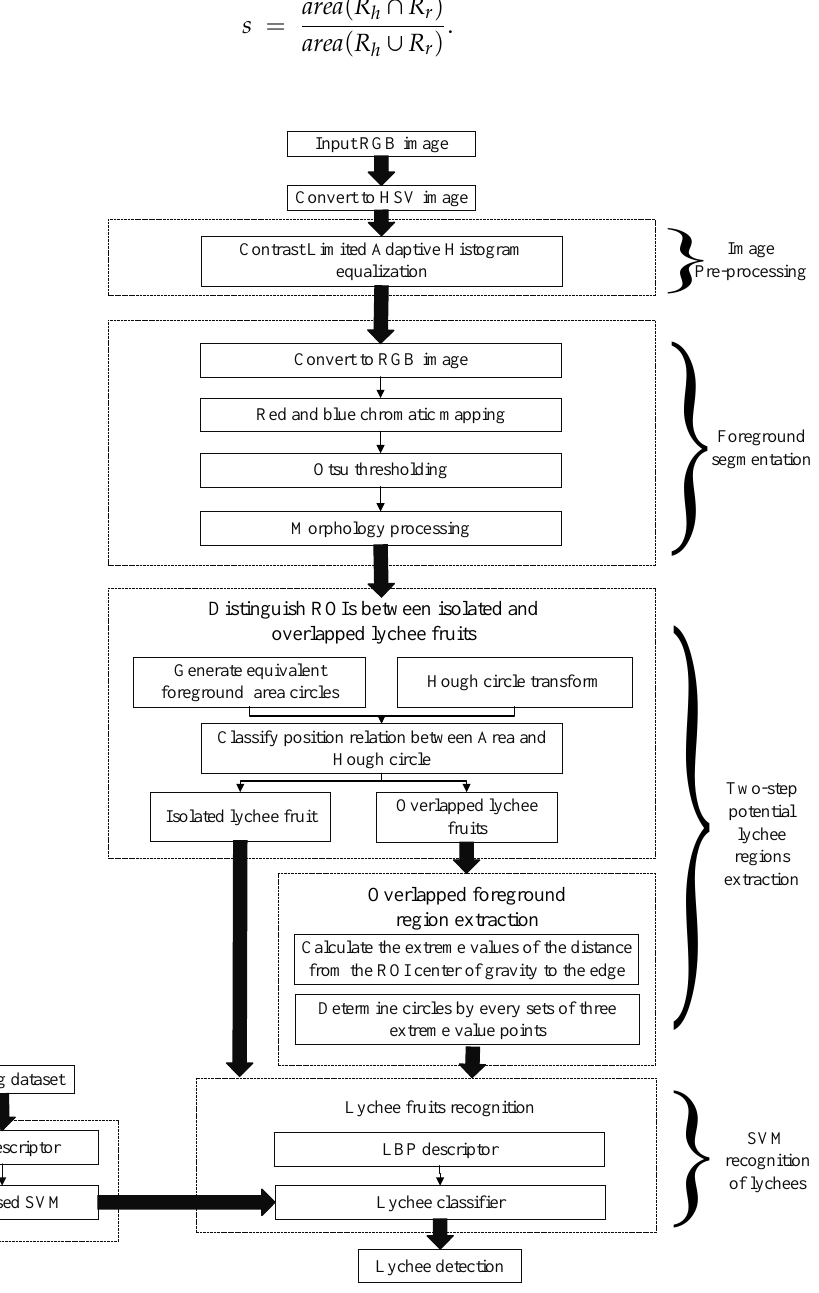
Figure 3. Flow diagram of the proposed lychee detection method.